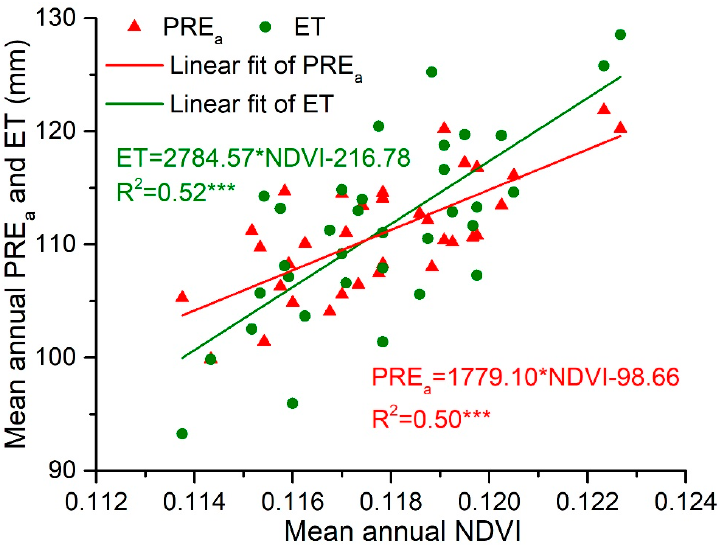
Figure 6. The correlation between mean annual available precipitation, mean annual evapotranspiration, and mean annual NDVI in all desert areas over the Silk Road Economic Belt between 1982 and 2015. *** indicates statistical significance at p < 0.01. PRE a —Available precipitation, ET —Evapotranspiration.